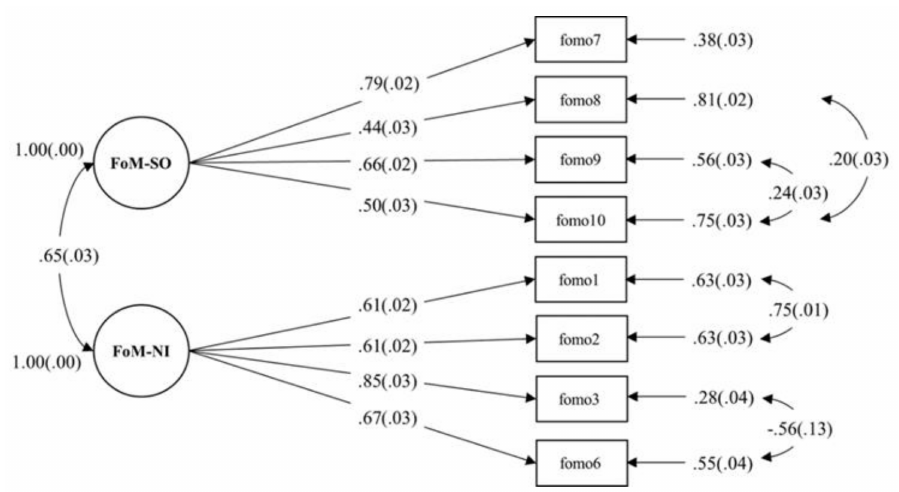
Figure 1. Path diagram for the CFA of the Fear of Missing Out Scale-Chinese version. FoM-SO represents fear of missing social opportunities; FoM-NI represents fear of missing novel information.